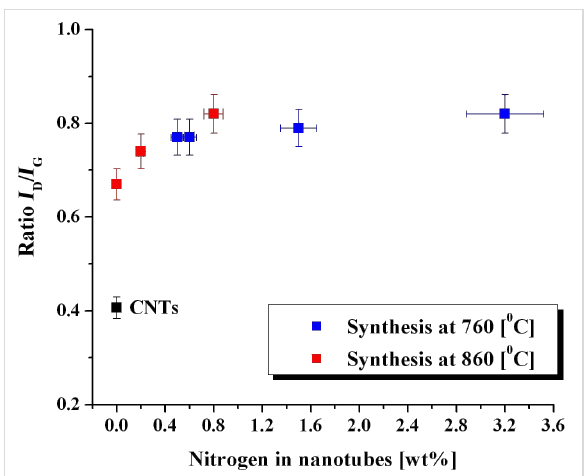
Figure 10: The ratio I D / I G vs the level of N-doping at 760 and 860 °C, as compared to pristine MWCNTs.